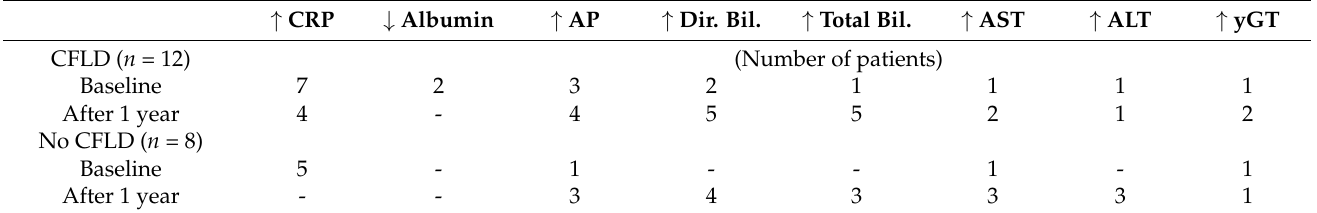
Table 3. CF patients with and without CFLD showing altered CRP and liver parameters at baseline and after 1 year of ETI therapy. ↑ Higher than normal values; ↓ lower than normal